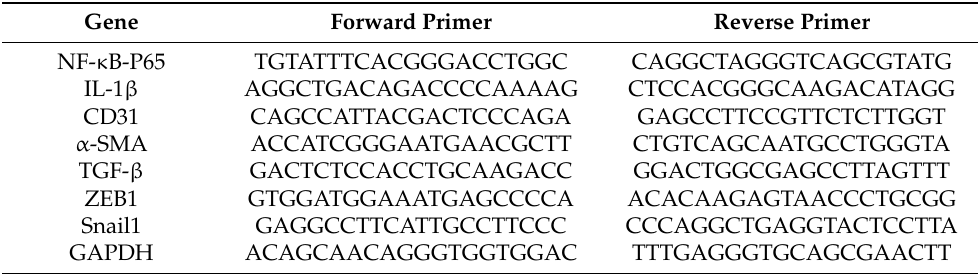
Table 2. List of primers and their sequences used in this